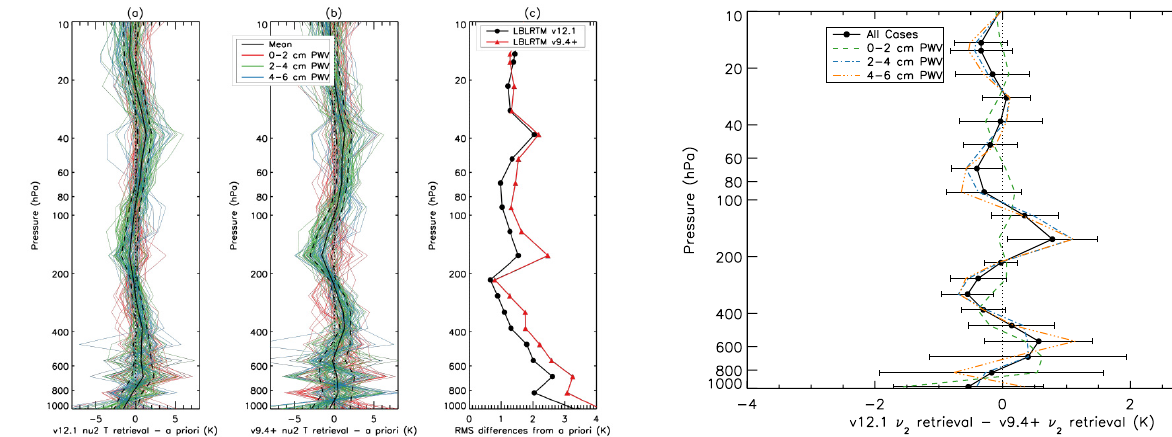
Fig. 7. (a) Differences between the final (a posteriori) temperature profile retrieved using LBLRTM v12.1 and the a priori temperature profiles. The thin red, green, and blue lines are the differences for the individual scans, and correspond to a PWV of 0–2, 2–4, and 4–6cm, respectively. The thick black line shows the mean differ- ence from the a priori over all 120 scans, with the black dashed lines showing the 25th and 75th percentiles. (b) As in (a) , but for LBLRTM v9.4 + . (c) RMS of the differences between the a poste- riori and a priori temperature profiles for v12.1 (black circles) and v9.4 + (red triangles). The RMS difference of the surface (skin) tem- perature from the a priori is 0.61K for v12.1 and 0.69K for v9.4 + .